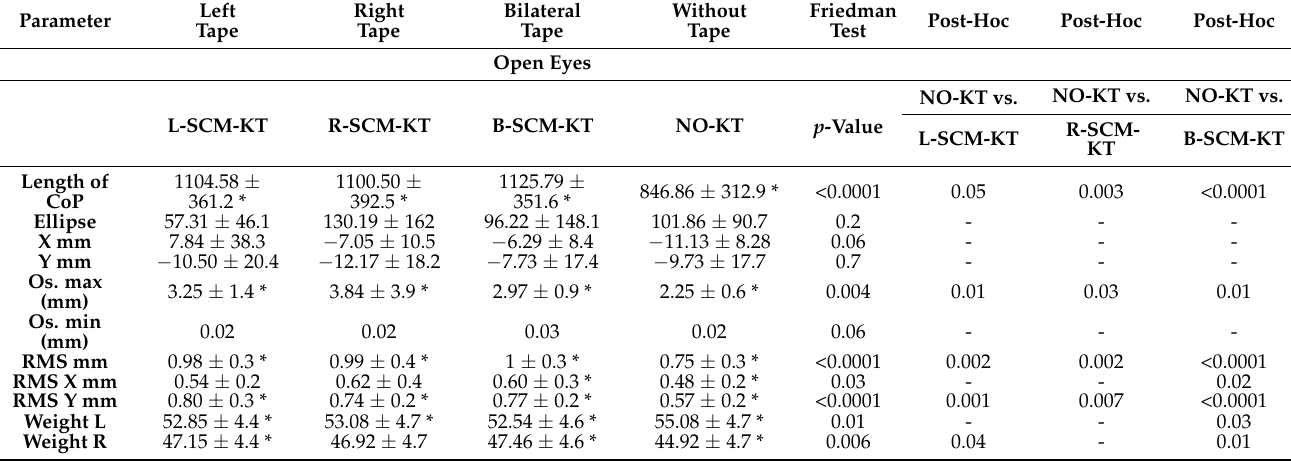
Table 2. Spatiotemporal parameters of static postural control. * p -value <